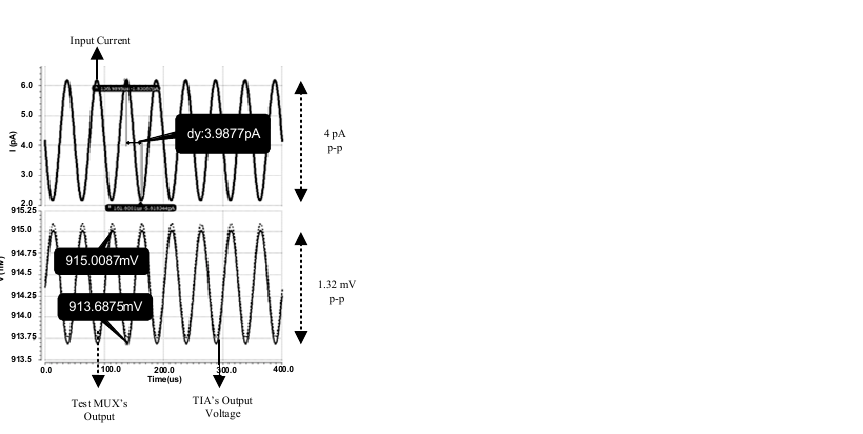
Figure 12. The transition simulation result for the minimum sensitivity of the TIA.